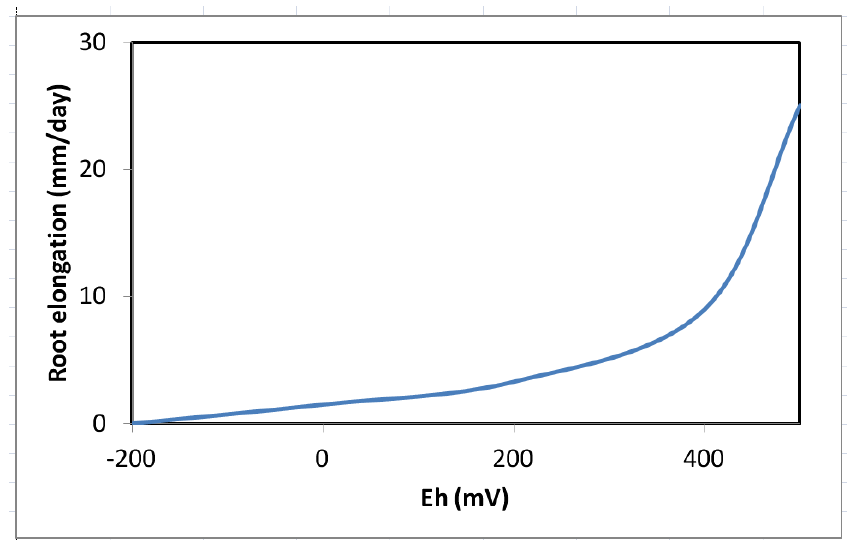
Figure 8. Responses of root elongation in Spartina patens , a brackish marsh species, to soil redox potential (Eh) (from Pezeshki and DeLaune [153]).